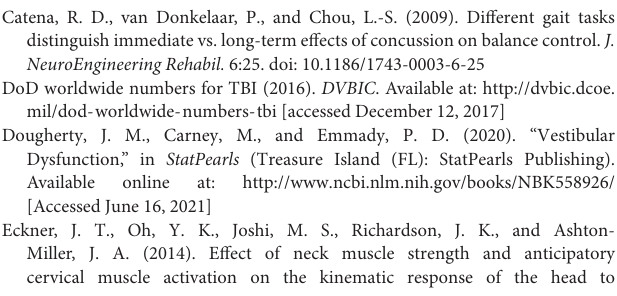
Supplementary Figure 1 | Photo-reflective marker placement for three-dimensional motion capture of the head and pelvis during